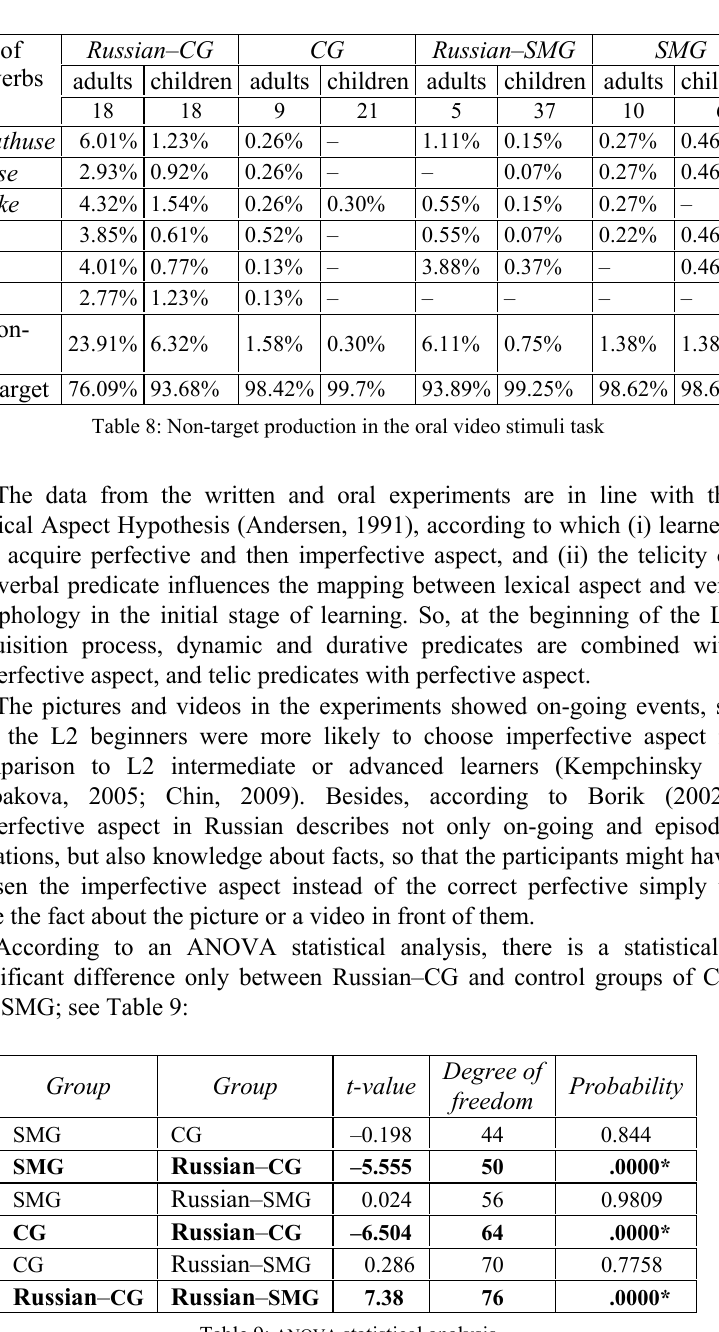
Table 9: ANOVA statistical